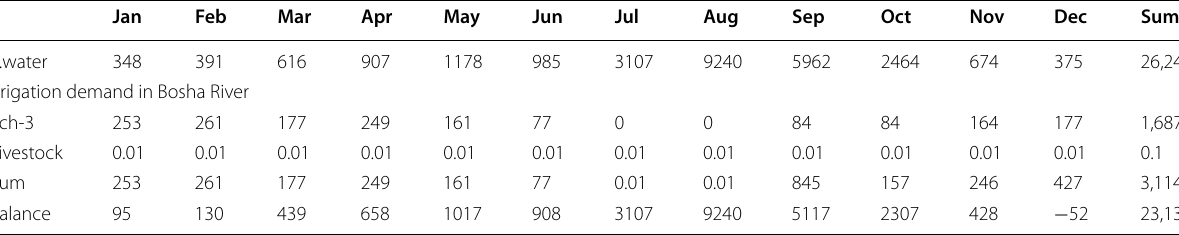
Table 10 Monthly water balance Bosha River (‘000 m 3 ) Jan